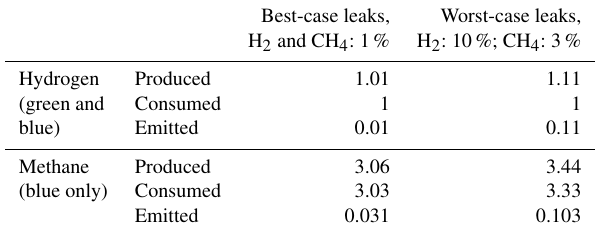
Table 2. Hydrogen and methane emissions (in kg) for deploying 1kg of either green or blue hydrogen based on best- and worst-case leak rates. We assume that 3 times the mass of hydrogen is needed in the form of methane for using methane as a feedstock for hydrogen production (Budsberg et al., 2015; Thibault et al.,